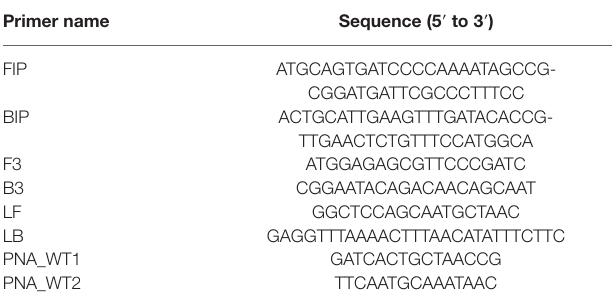
TABLE 3 | LAMP primers and PNA sequences for detecting alleles of ms1-2 with the 30-bp deletion.